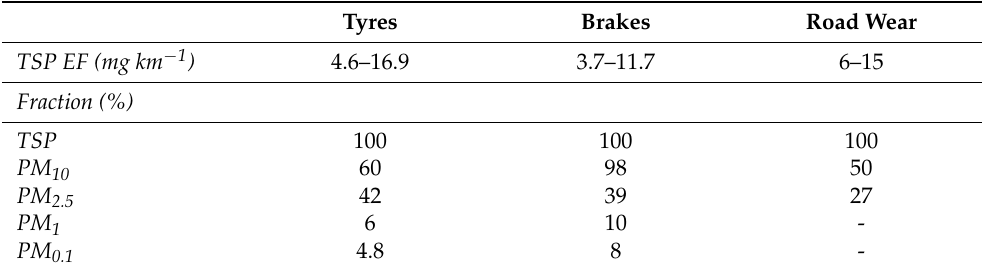
Table 6. Emission factors ranges for vehicles from two-wheeled light heavy-duty vehicles according to the Tier 2 methodology